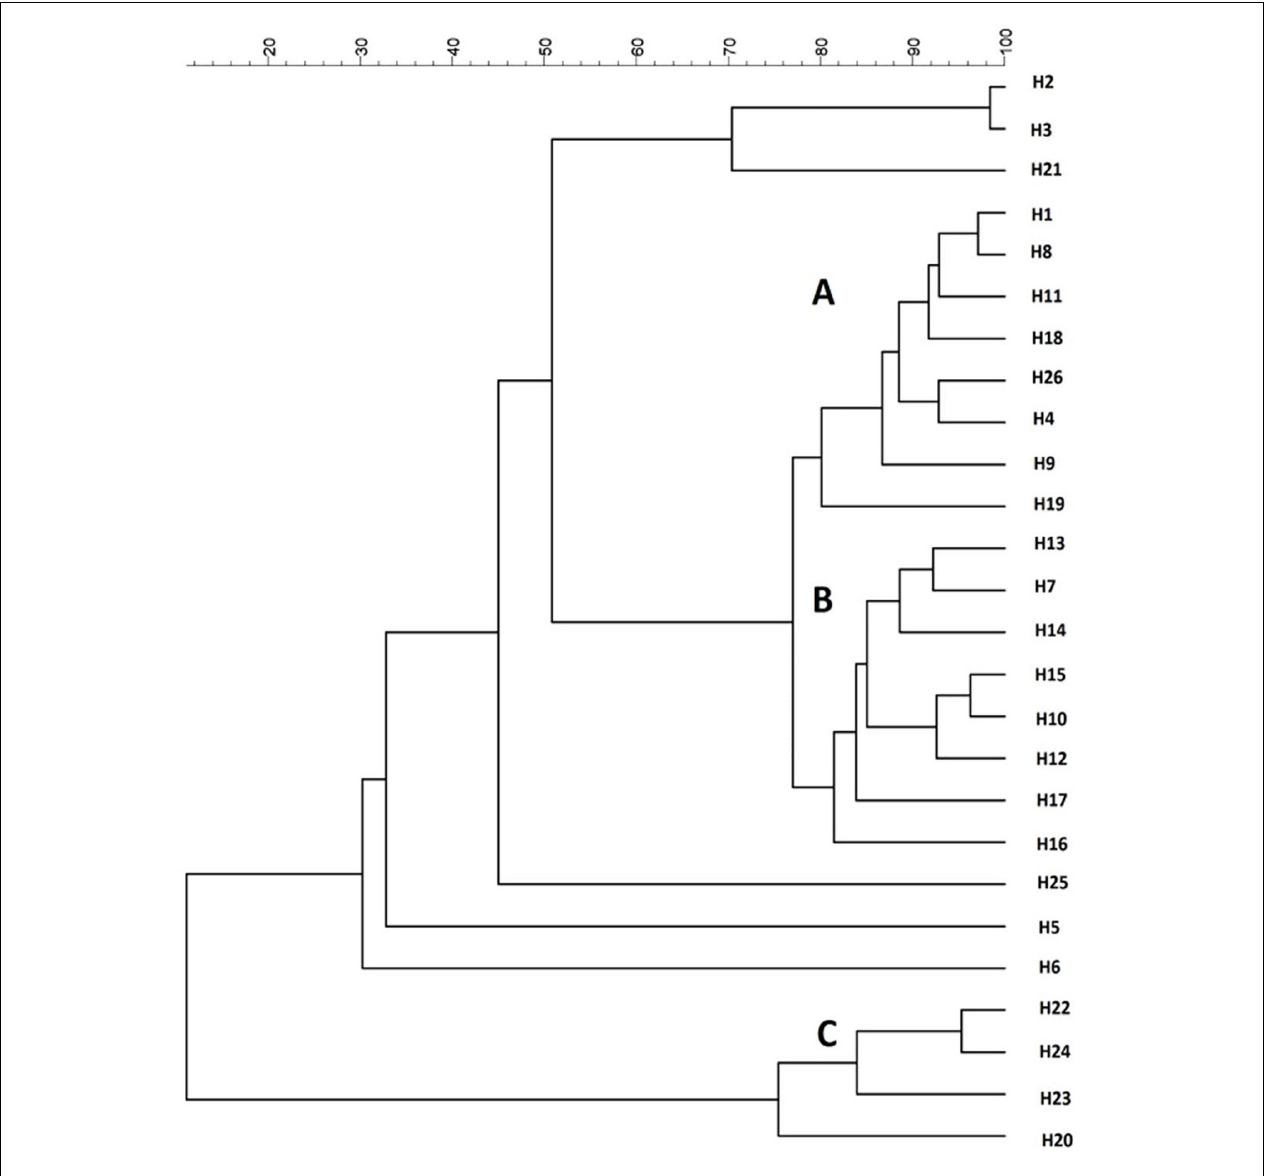
FIGURE 1 | Cluster analysis with UPGMA method and Pearson distance of 26 H. uvarum profiles based on MSP-PCR with (GTG) 5